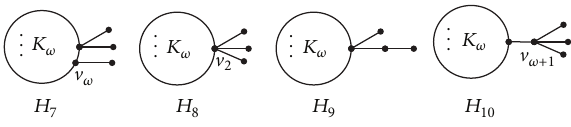
Figure 10: Graphs 𝐻 7 , 𝐻 8 , 𝐻 9 , 𝐻 10